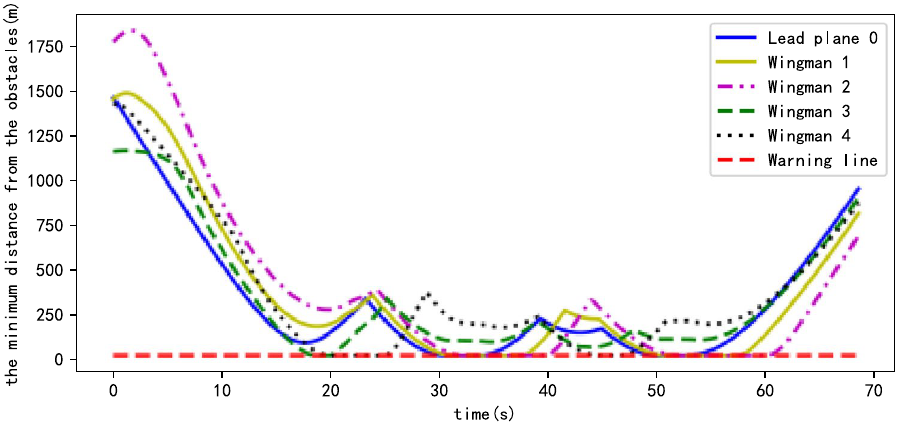
Figure 13. Minimum distance between UAVs and